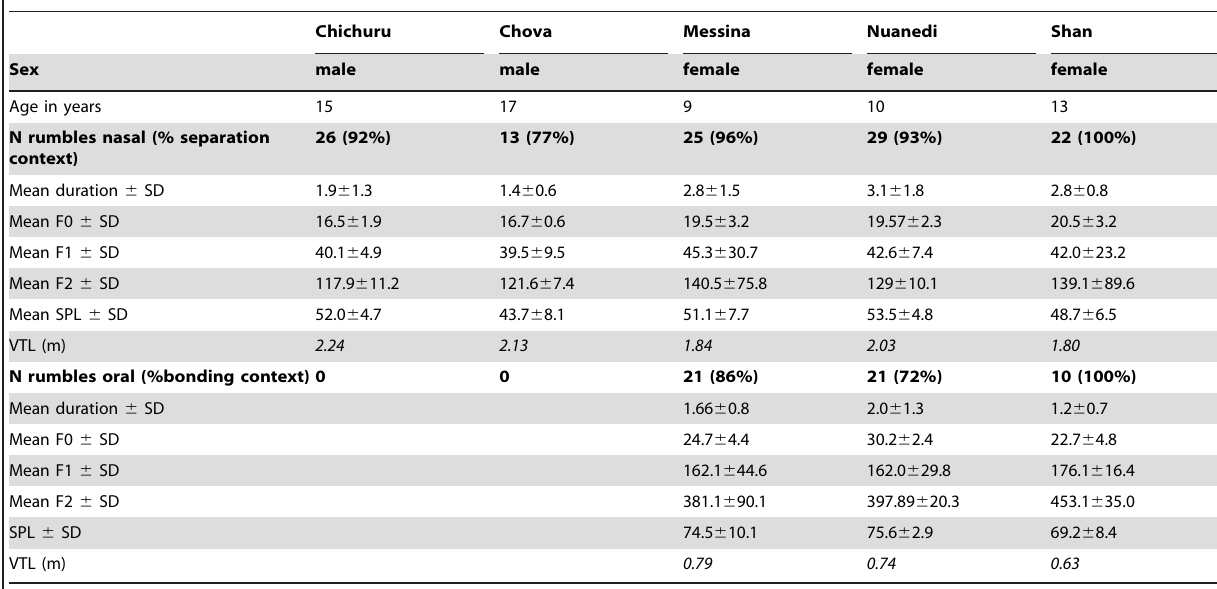
Table 1. Results of the acoustic analysis.